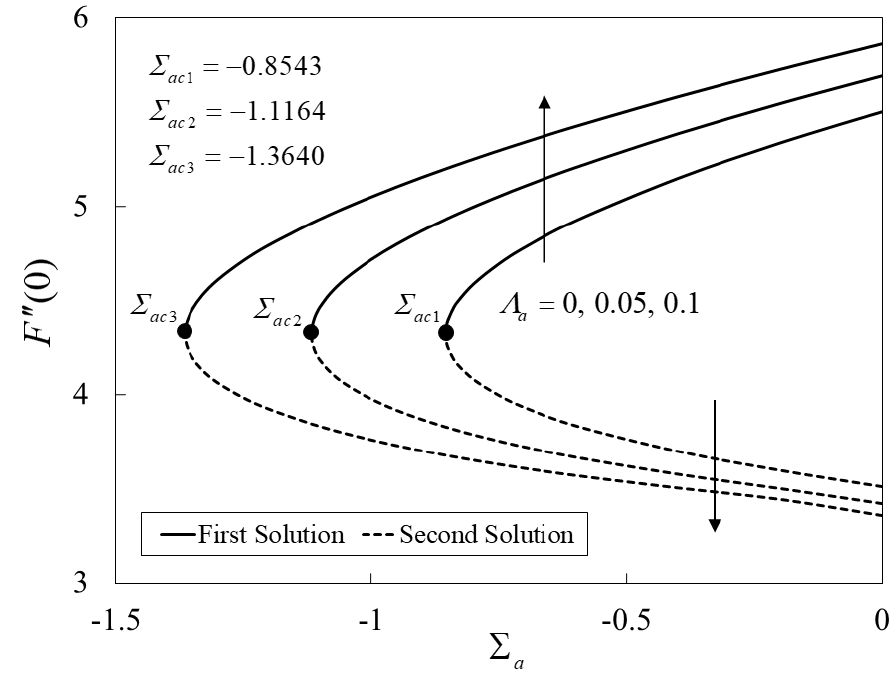
Figure 2. Variation in the skin friction coefficient F (cid:48)(cid:48) ( 0 ) with Σ a for different values of Λ a .